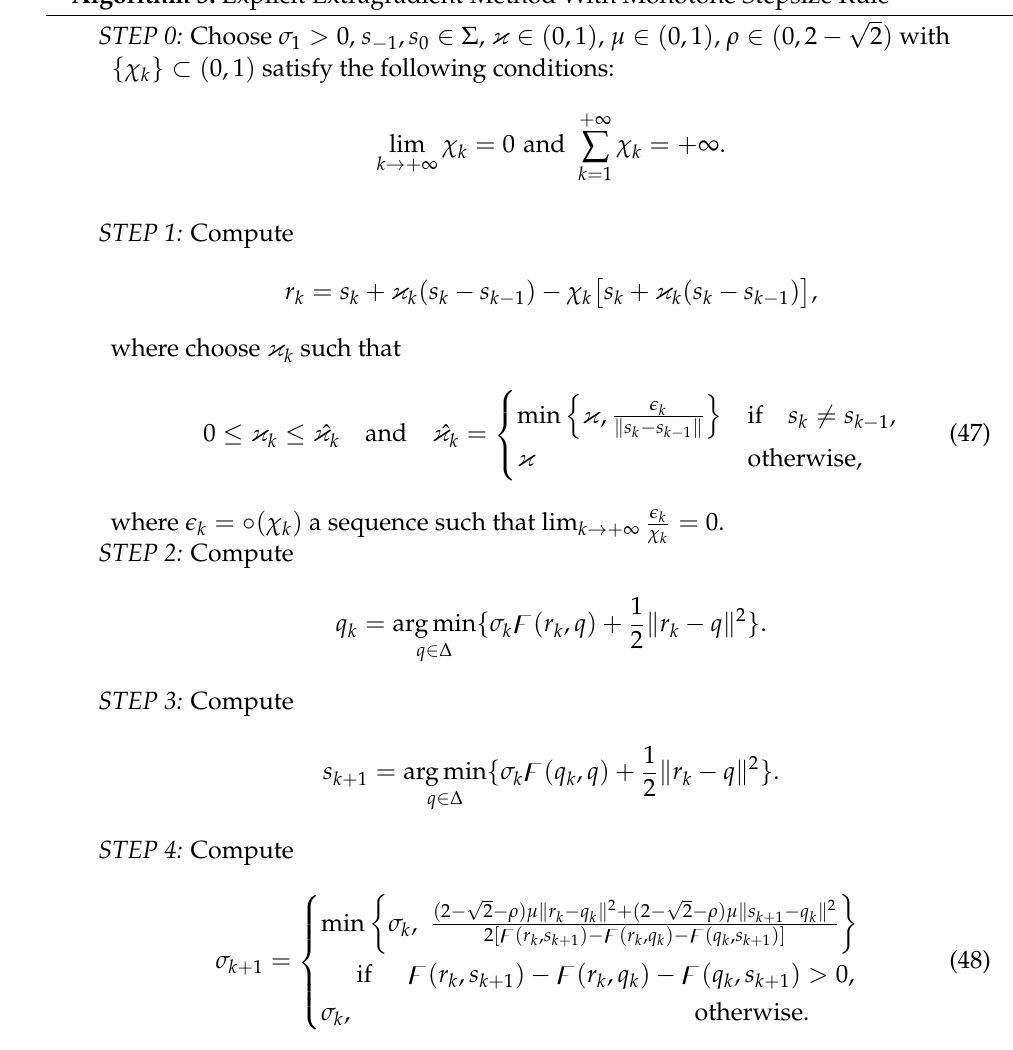
Algorithm 3: Explicit Extragradient Method With Monotone Stepsize Rule